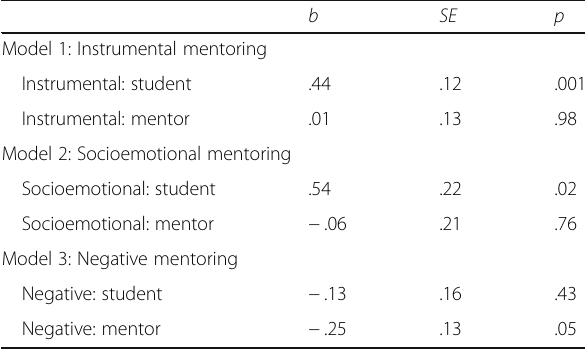
Table 2 Findings from multiple regression analyses predicting scientist identity from mentoring